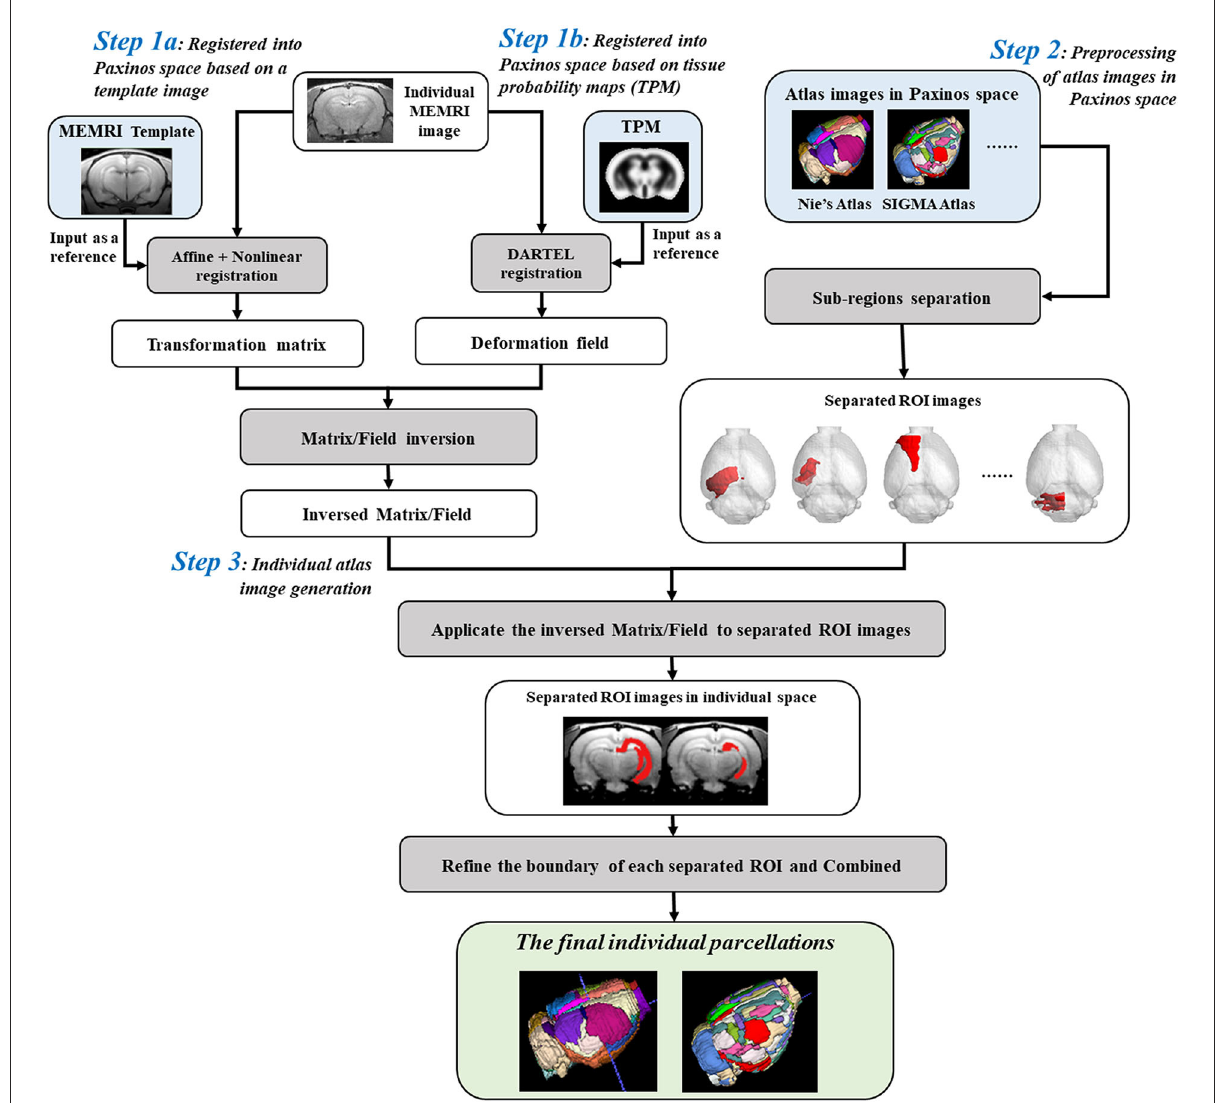
FIGURE1 Flow chart for creating individual parcellations of manganese-enhanced magnetic resonance imaging (MEMRI) image of rat brain. Step 1 : The individual MEMRI image was registered into Paxinos space either by affine/nonlinear transformations based on the MEMRI template image ( Step 1a ), or by DARTEL algorithm based on the tissue probability maps (TPM) ( Step 1b ), and the transformation matrix/deformation field was obtained, named as Matrix sn / Deform y . Inverse transformation of the Matrix sn / Deform y was then calculated, named InvMatrix sn / InvDeform y . Step 2 : All the regions of interests (ROIs) defined in atlas images in Paxinos space were firstly separated and resaved as single-ROI mask images. Step 3 : The separated ROI mask images were transformed into individual space via the InvMatrix sn / InvDeform y using 4th B-spline interpolation algorithm. The contour of each transformed ROI was identified and further refined by image erosion and expansion operator. Then, each refined ROI was given a unique integer as an index and then combined into a new atlas image. This combined atlas image was the final individual parcellations of MEMRI